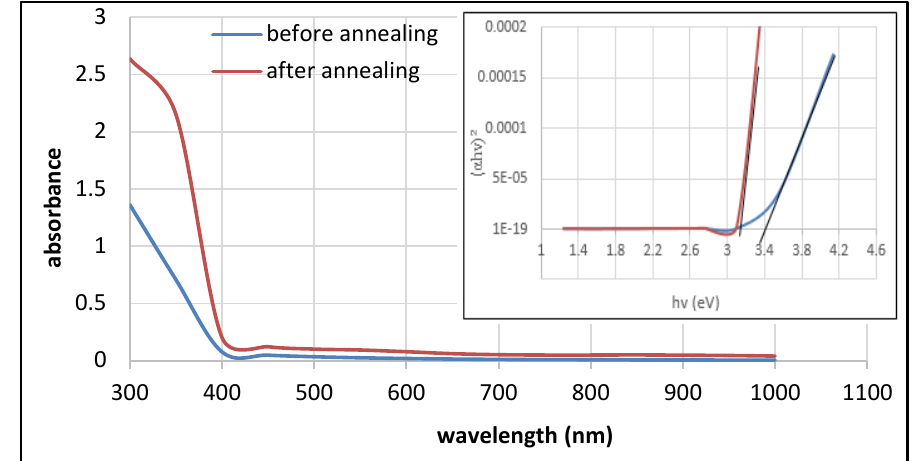
Fig. 5: The absorption spectra of nanostructured ZnO thin film and its band gab after and before annealing